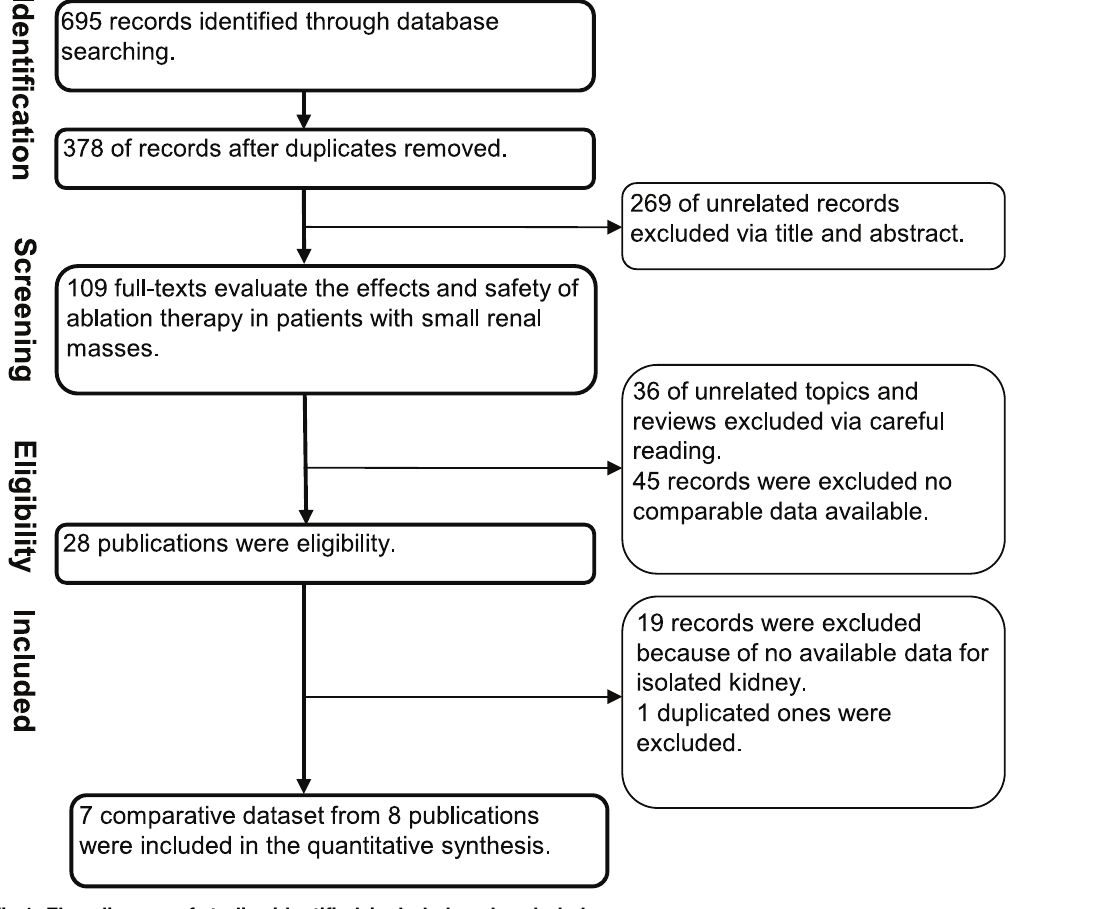
Fig 1. Flow diagram of studies identified, included, and excluded.